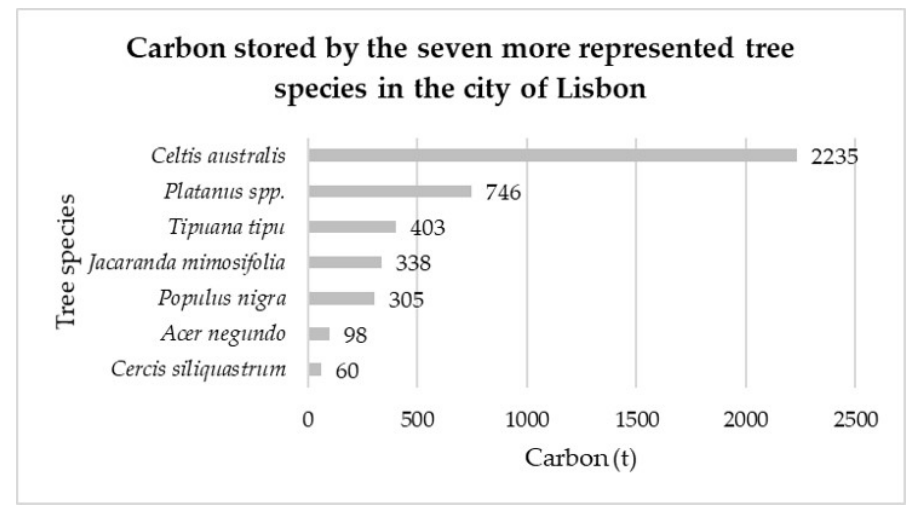
Figure 4. Total carbon stored by each one of the seven more represented tree species in the city of Lisbon.